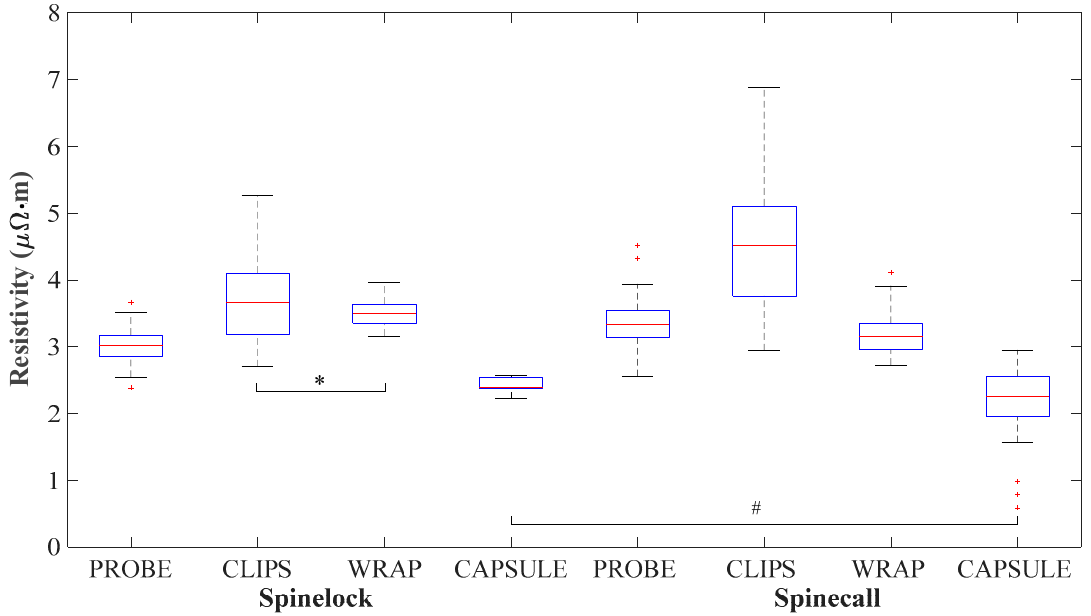
Figure 4. Electrical resistivity measured by each coupling method for each analyzed pedicle screw. Coupling methods with no statistical difference ( p > 0.05) within (*) and between (#) screws are denoted, as well as the existence of outliers (+).